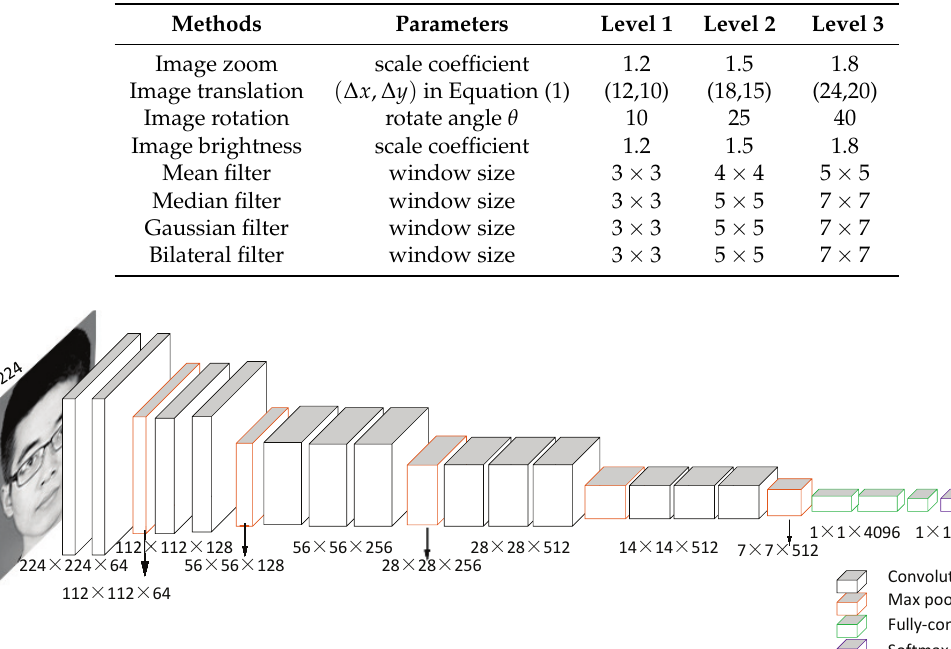
Table 1. The parameters of data augmentation methods with different levels.